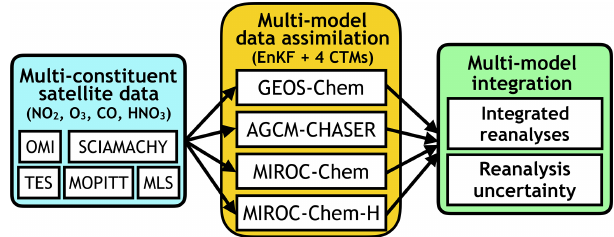
Figure 1. Schematic diagram of the MOMO-Chem framework. The MOMO-Chem utilizes four different CTMs and applies a common EnKF approach to investigate the importance of forecast model per- formance and model sensitivities for data assimilation analysis. This framework also provides multi-model integrated analysis fields and its uncertainty